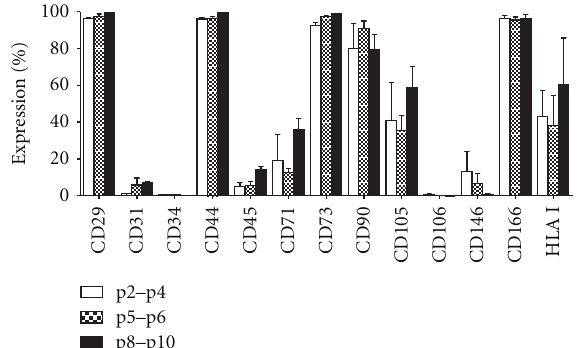
Figure 3: Flow cytometric analysis of cell surface marker expression in DPSCs at di ff erent passages. Results are expressed as arithmetic mean ±